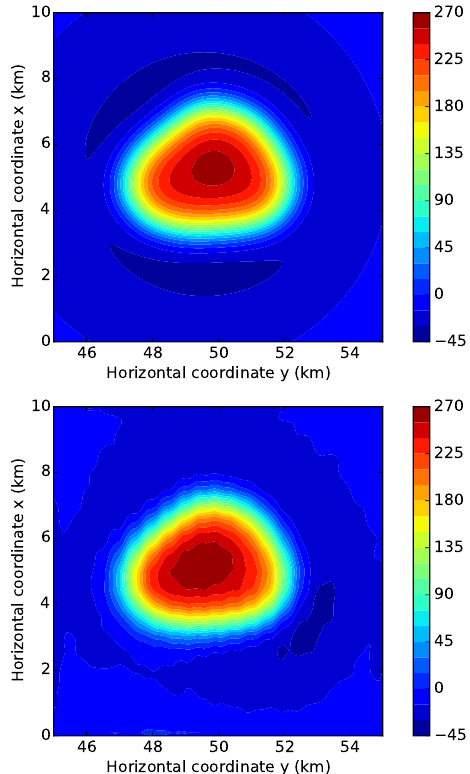
Figure 13. Igneous intrusion. The upper panel shows the true reduced-to-the-pole anomaly produced by the synthetic bodies shown in Fig. 10. The lower panel shows the reduced-to-the-pole anomaly obtained from the noise-corrupted total-field anomaly shown in Fig. 11. These anomalies were calculated at the same points of the total-field anomaly shown in Fig. 11. The reduction to the pole was calculated by using the robust estimates of declina- tion e D and inclination e I shown in Table